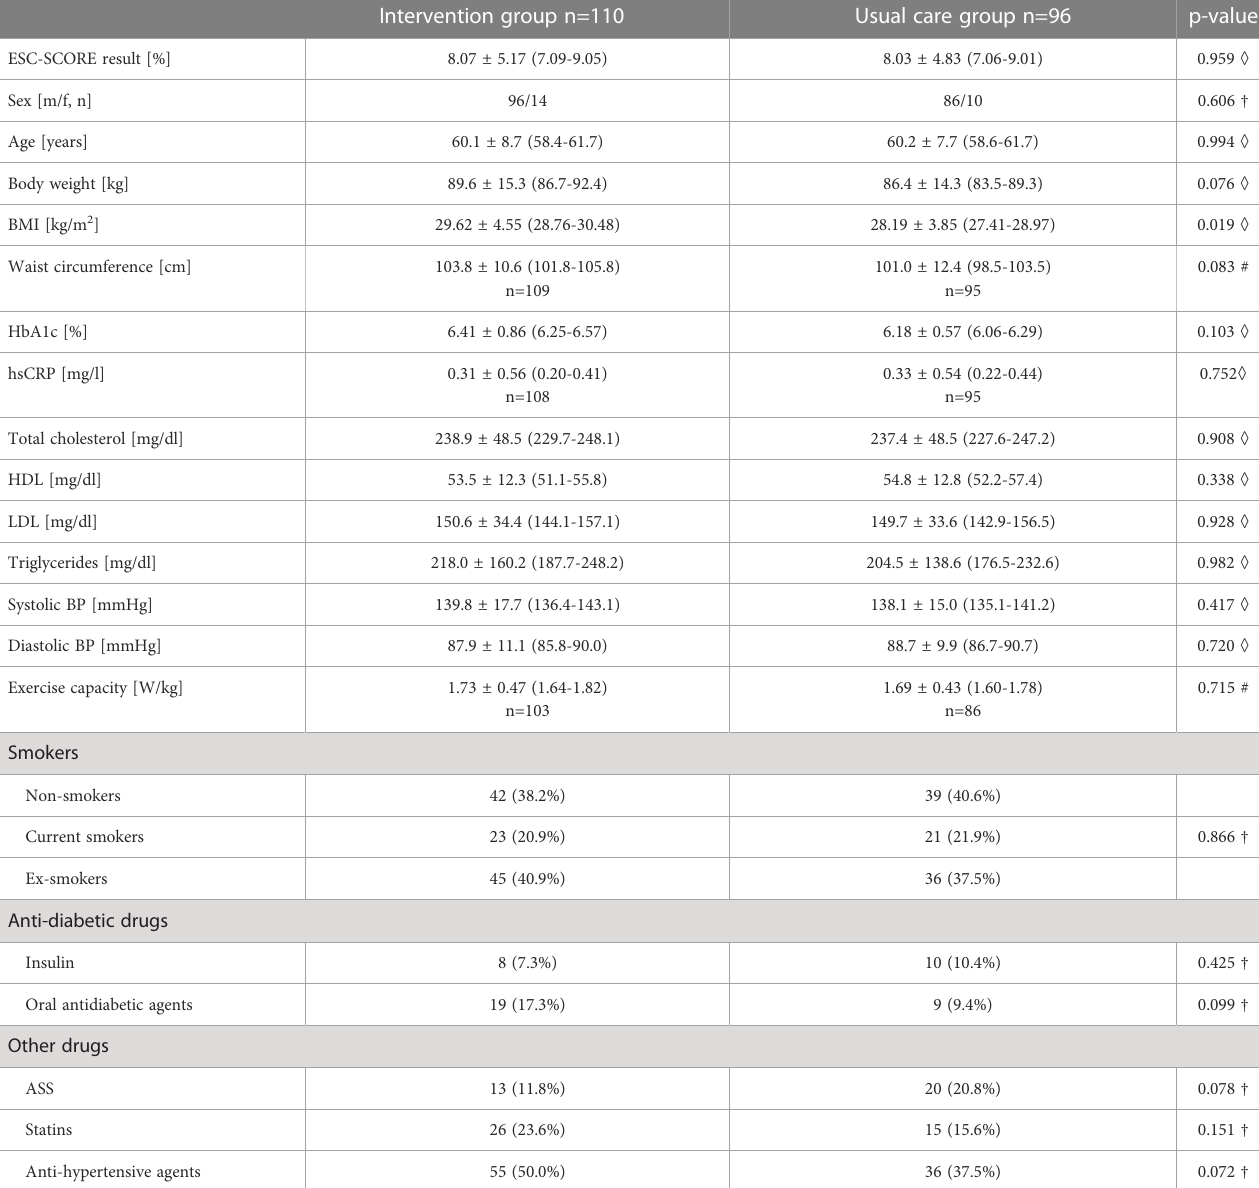
TABLE 2 Study participants´ baseline (T0)